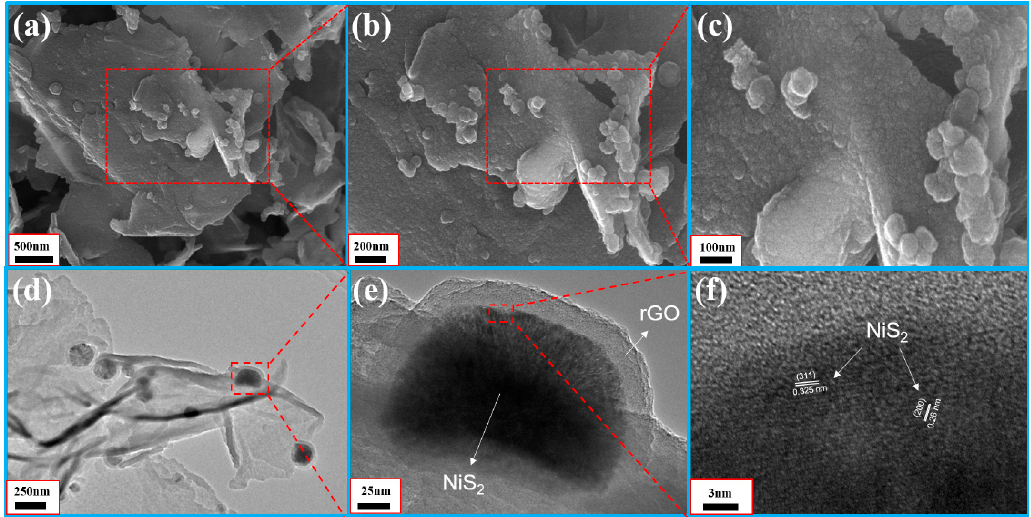
Figure 3. Scanning electron microscope (SEM) images of the NiS 2 @rGO/PPy ternary composite ( a – c ); transmission electron microscope (TEM) images of NiS 2 @rGO/PPy ternary composite ( d , e ); high-resolution TEM (HRTEM) images of the NiS 2 @rGO/PPy ternary composite ( f ).